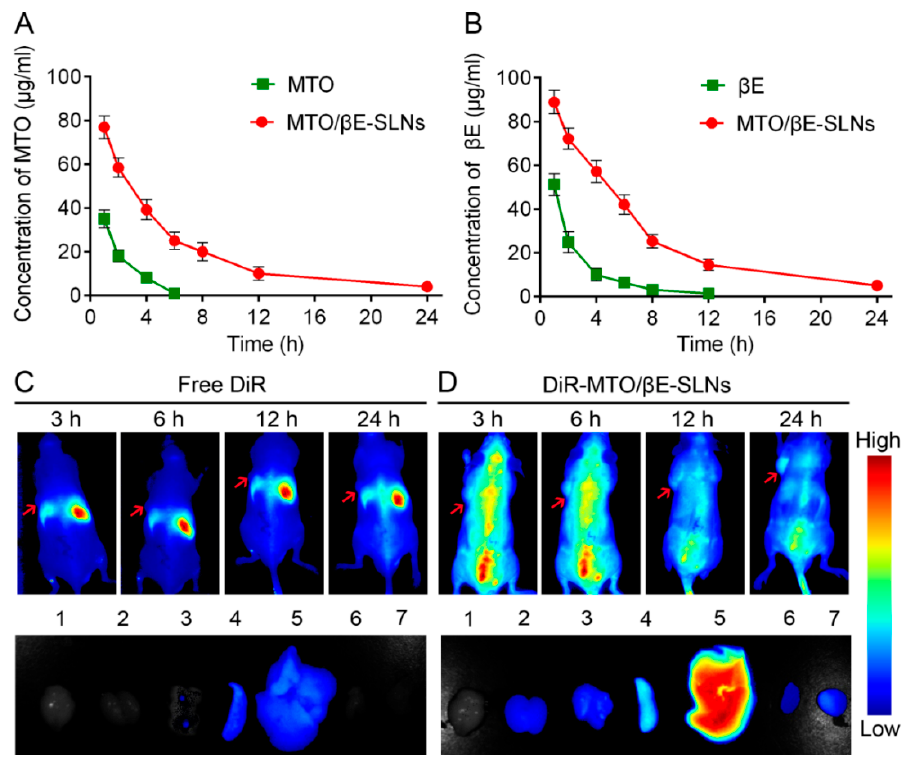
Figure 5. ( A ) The drug plasma concentration–time curve of MTO after an intravenous injection of free MTO and MTO / β E-SLNs at a dose of 2 mg / kg. ( B ) The drug plasma concentration–time curve of β E after an intravenous injection of free β E and MTO / β E-SLNs at a dose of 4 mg / kg. Measurements were performed, and data are presented as means ± SD ( n = 6). ( C ) In vivo biodistribution of free DiR and ex vivo imaging of excised organs and tumor after 24 h post injection of free DiR in K562 / DOX tumor-bearing nude mice. 1: brain; 2: kidney; 3: lung; 4: spleen; 5: liver; 6: heart; 7: tumor. ( D ) In vivo biodistribution of DiR-MTO / β E-SLNs and ex vivo imaging of excised organs and tumor after 24 h post injection of DiR-MTO / β E-SLNs in K562 / DOX tumor-bearing nude mice. 1: brain; 2: kidney; 3: lung; 4: spleen; 5: liver; 6: heart; 7: tumor.